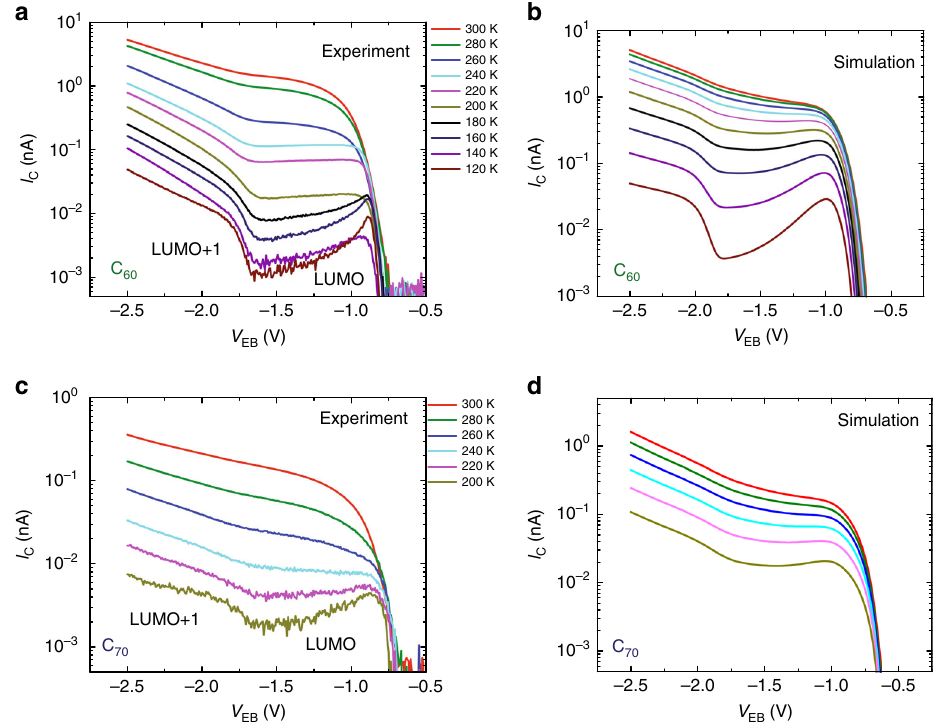
Fig. 2 Temperature dependence of the hot-electron current. a Temperature dependence of the direct hot-electron current I C of a Au/C 60 based in-device molecular spectroscopy (i-MOS) device for negative emitter-base bias V EB < 0 V, and without any applied collector-base bias, V CB = 0 V. b Simulated temperature dependence of I C for the Au/C 60 device at V CB = 0 V. c Temperature dependence of I C of a Au/C 70 based device for negative emitter-base bias V EB < 0 V, and without any external bias V CB = 0 V. d Simulated temperature dependence of I C for the Au/C 70 device at V CB = 0